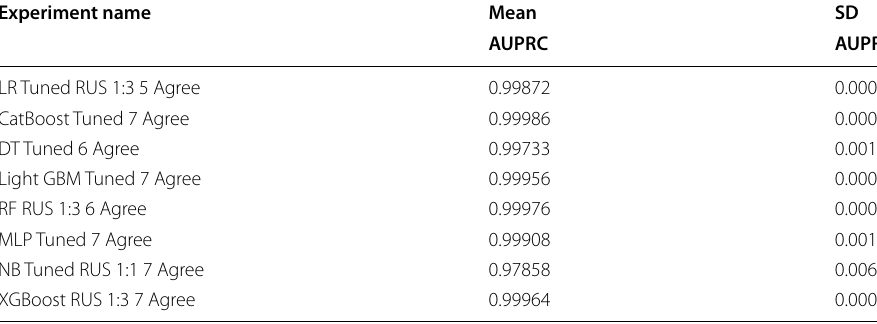
Table 6 Maximum AUPRC by classifier for the information theft attack type; mean and standard deviations of AUPRC, (10 iterations of 5-fold cross-validation)